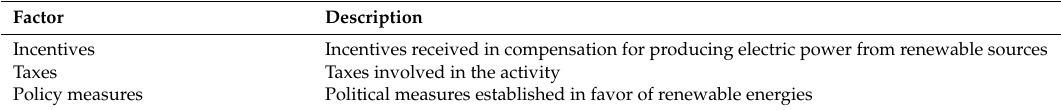
Table 6. Description of factors involved in the optimal location in the wind farms. Political category.